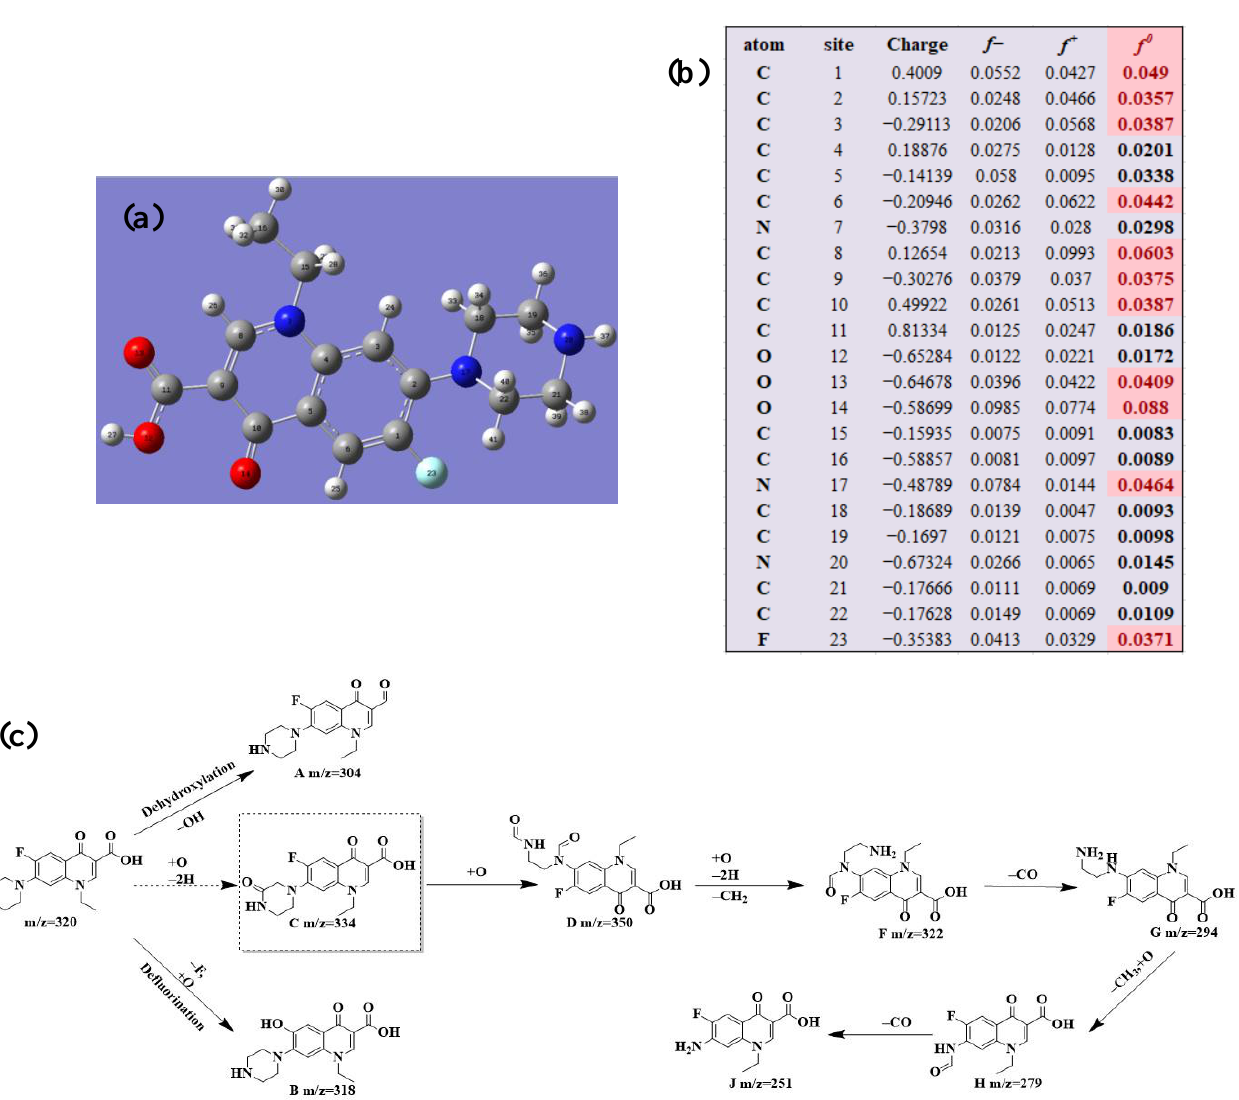
Figure 6. ( a ) Chemical structure, ( b ) NPA charge distribution and Fukui index ( f 0 ) and ( c ) degradation pathway of NOR.